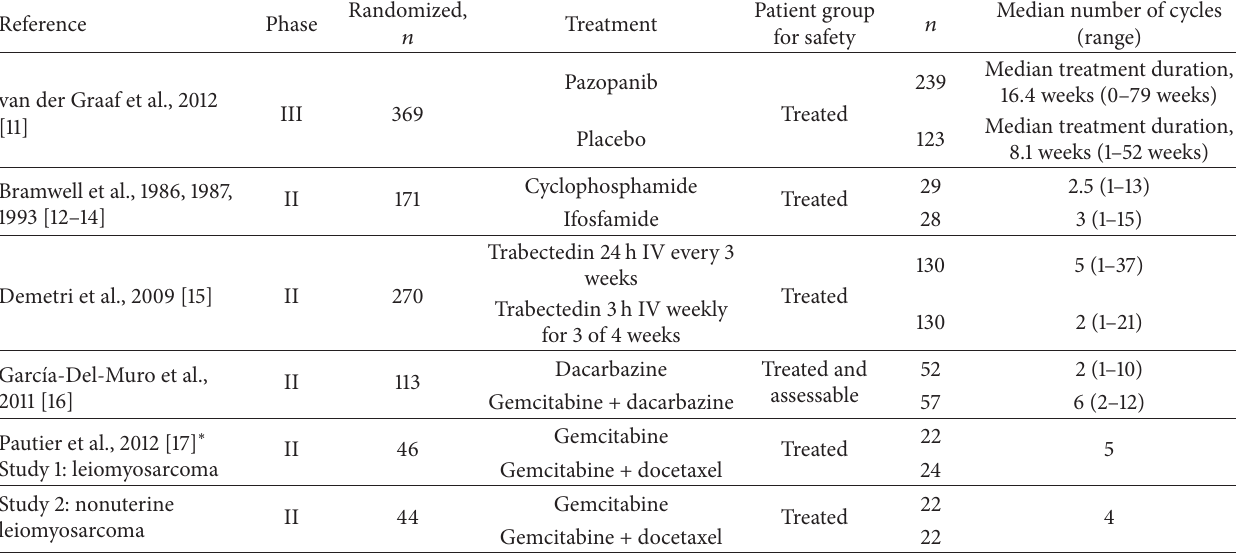
Table 1: Characteristics of included studies after protocol